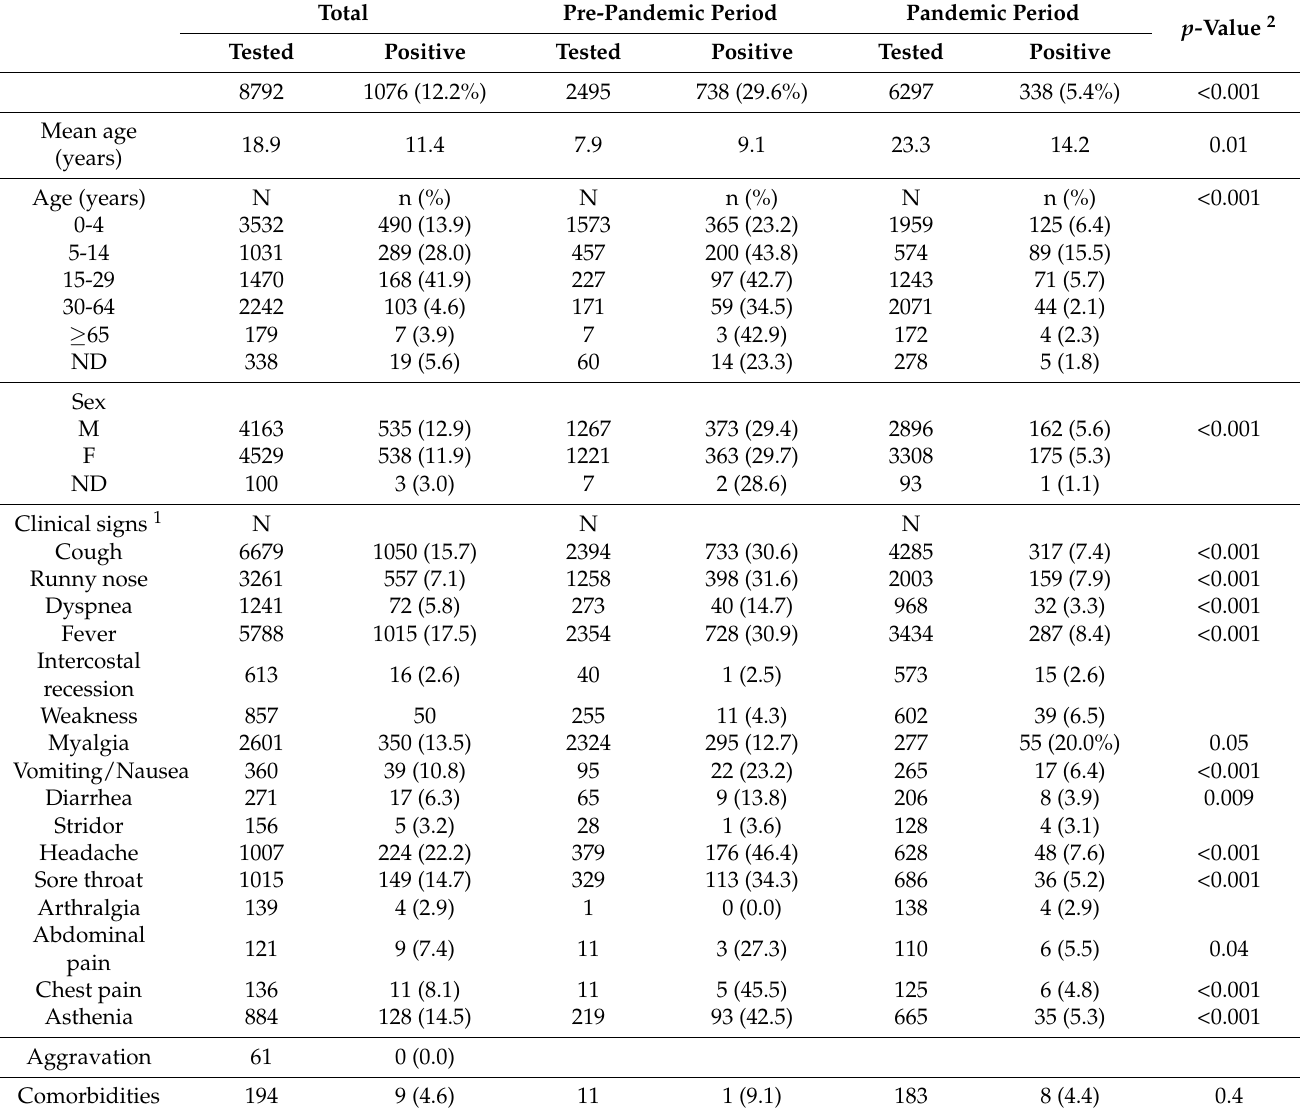
Table 2. Characteristics of influenza-positive cases detected among patients enrolled through the Influenza Surveillance Network, Madagascar from January 2018 to May 2022.